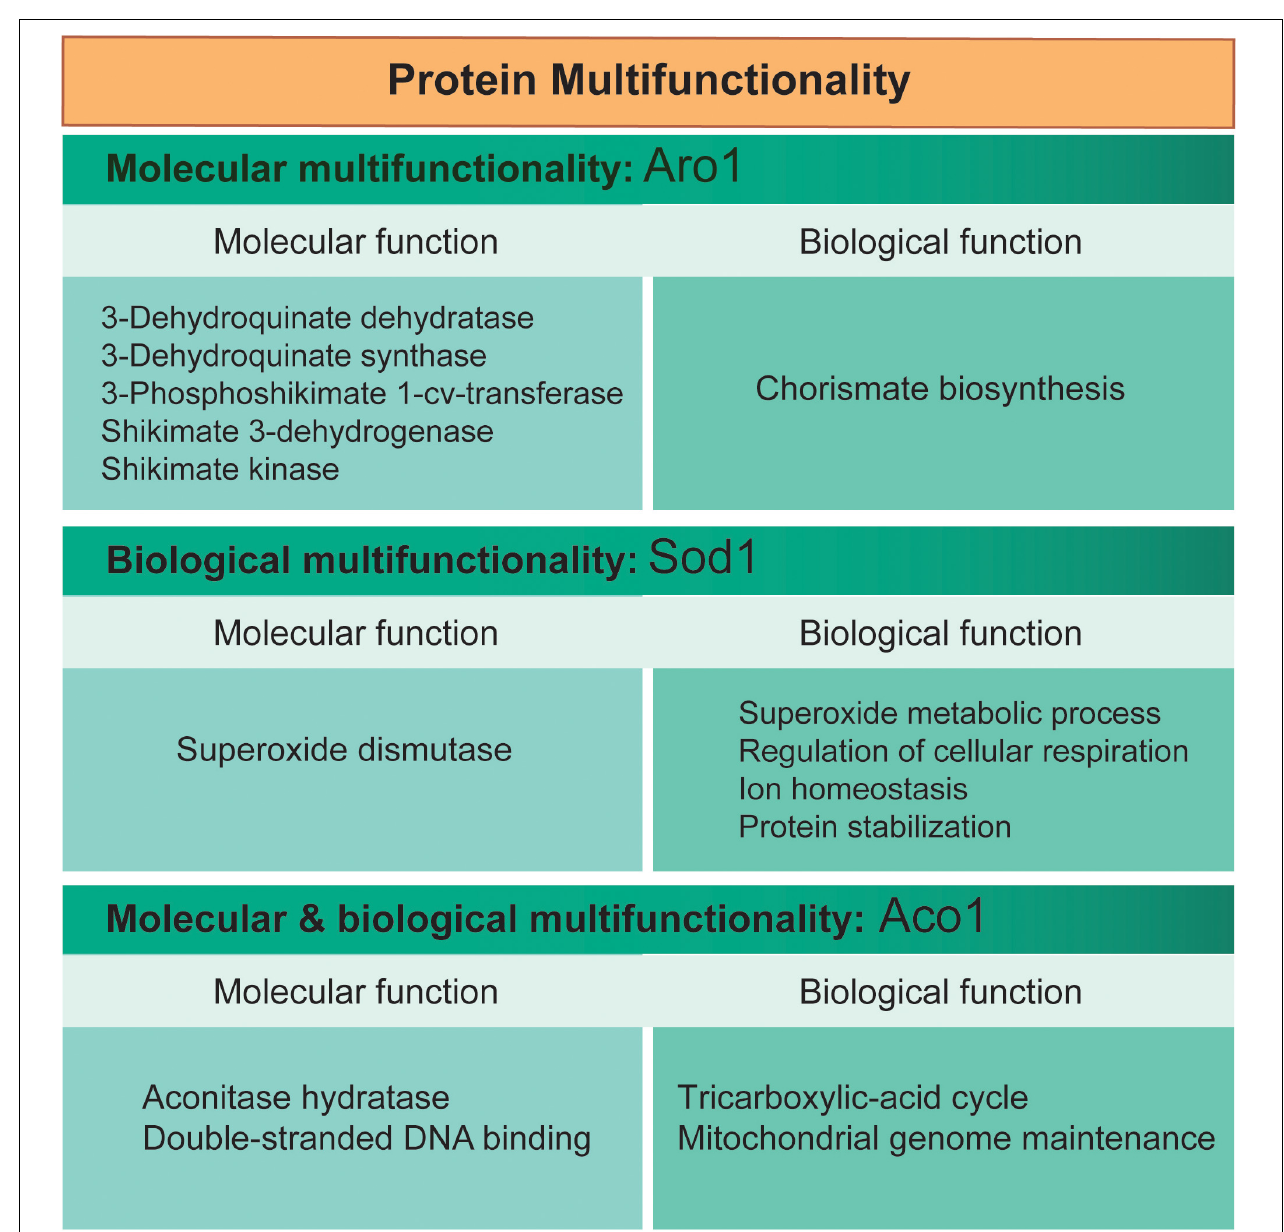
FIGURE 2 | Different kinds of multifunctional proteins. Different kinds of multifunctional proteins may be described based on their “molecular” or “biological” functions. Examples are provided for three multifunctional proteins from S. cerevisiae (Aro1, Sod1, and Aco1); functional annotations (GO terms) are from the Saccharomyces Genome Database